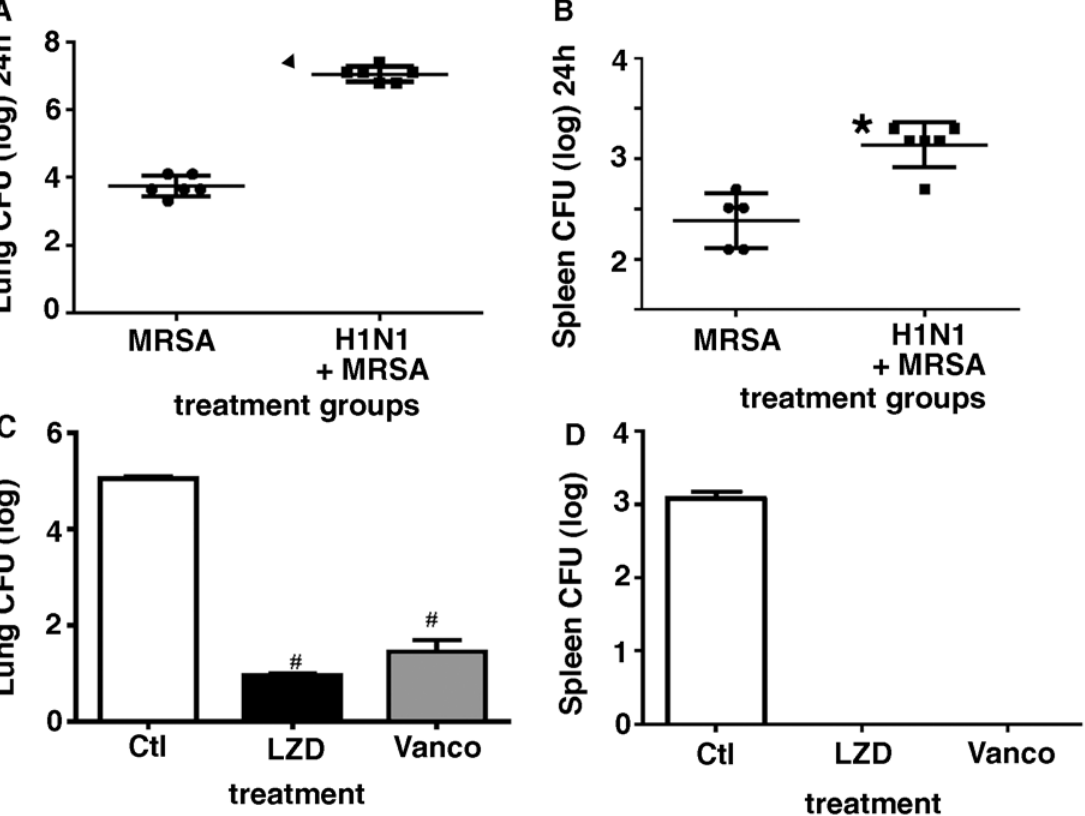
Figure 1. Mice infected with cMRSA post H1N1 have higher bacterial burden as compared to virus infected animals alone and treatment with antibiotics post bacterial challenge decreases bacterial burden in lung as well as protects against systemic dissemination as compared to saline treated animals. C57BL/6 mice were infected with 100pfu H1N1 i.n. and on day 7 challenged with vehicle or 5×10 7 cMRSA, lungs and spleen harvested 24 hours post bacterial challenge and bacterial burden assessed (Fig. 1A, 1B). WT mice were infected with H1N1 100 pfu i.n. and on day 7 challenged with 5×10 7 cfu cMRSA i.t., infected mice were treated with either vehicle or antibiotics LZD (80mg/kg i.p.) or Vanco (110 mg/kg i.p.). Lungs (Fig. 1C) and spleen (Fig. 1D) were harvested 24 hours post bacterial challenge and CFU quantitated. n = 6 in each group, experiments repeated thrice. #p < 0.01 as compared to vehicle treated group. Error bars represent mean (cid:2) SEM.